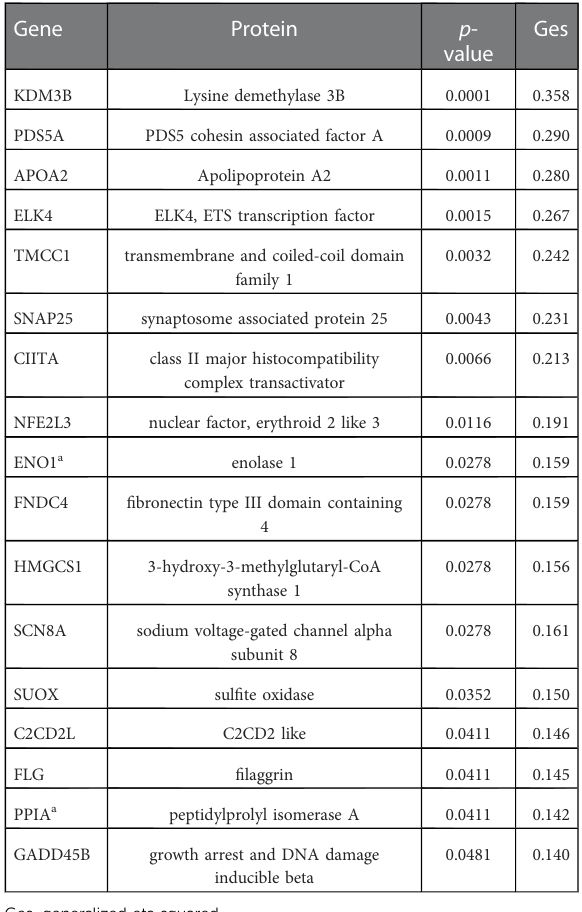
TABLE 4 List of antigens signi fi cantly different in JIA patients with and without uveitis.